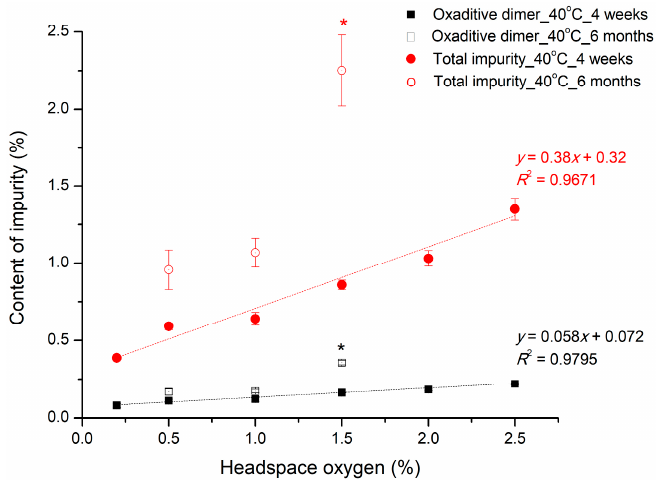
Figure 8. Effect of headspace oxygen level (%) on pemetrexed degradation in aqueous solution induced by accelerated condition at 40 °C for four weeks and six months. * indicate significant difference compared to 1.0% headspace oxygen sample ( p <